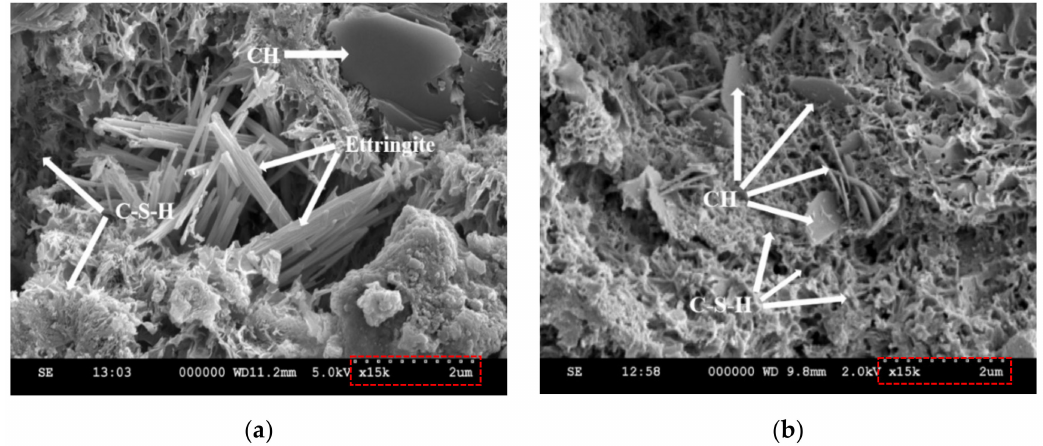
Figure 17. SEM observations after 56 curing days of ( a ) control mix and ( b ) mix